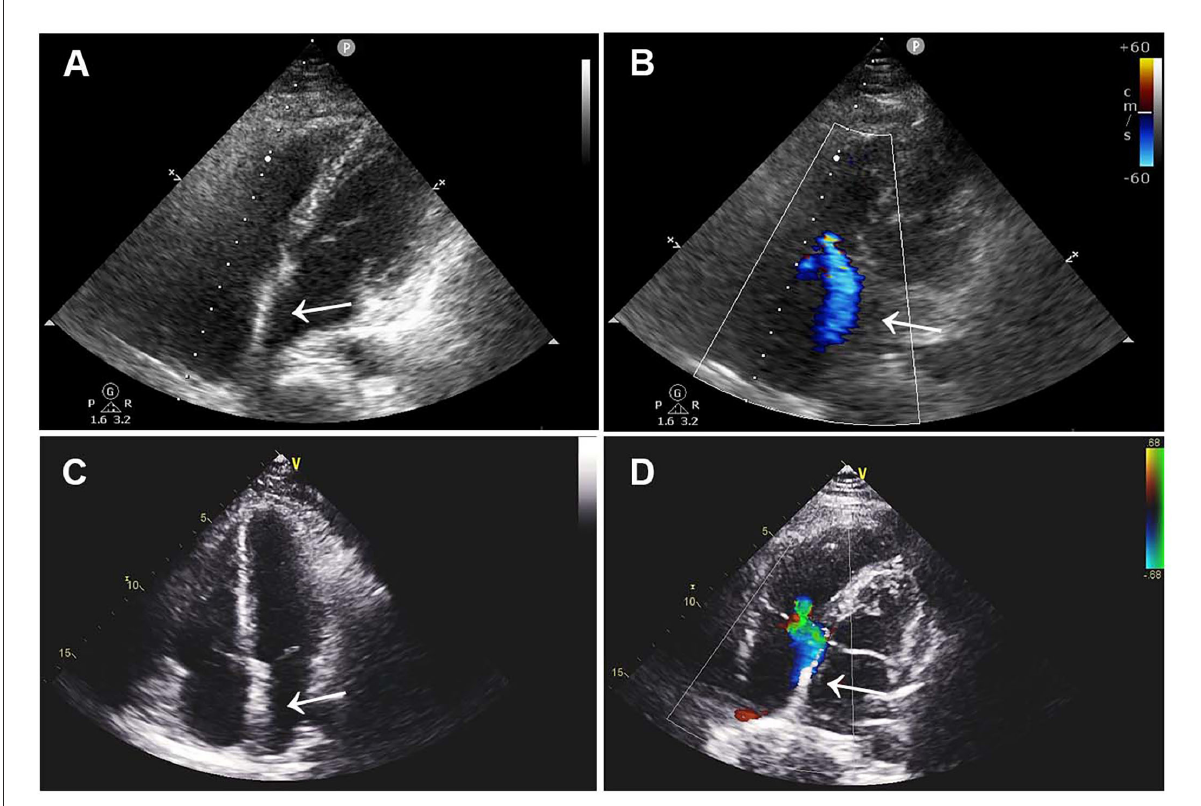
FIGURE3 Postoperative TTE images. (A,B) TTE images 1 month after surgery showed continuous atrial septum without shunt and thrombus. (C,D) Three-month postoperative TTE images showed no novel shunt and no thrombus. TTE, transthoracic